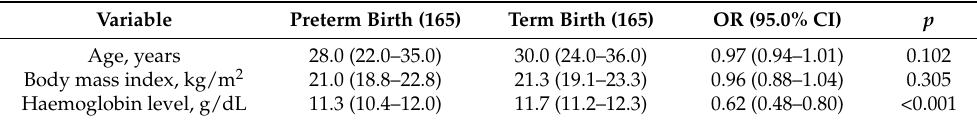
Table 1. Univariate analysis of the factors (continuous variables) associated with preterm birth at Omdurman hospital in Sudan,